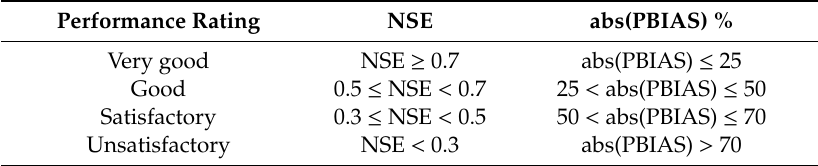
Table 5. Performance ratings of the Nash–Sutcli ff e e ffi ciency (NSE) and percent bias (PBIAS) statistics for daily